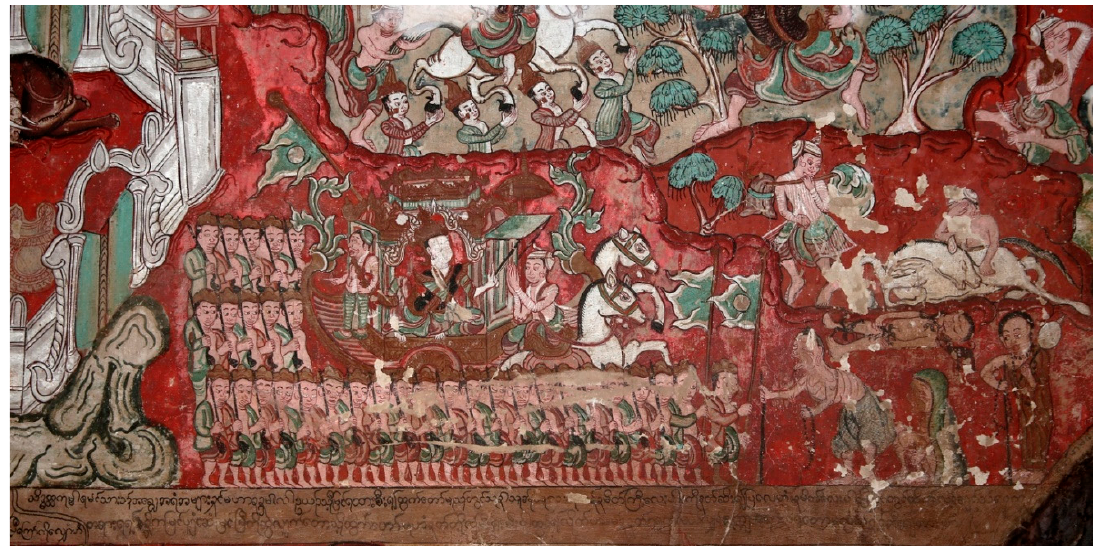
Figure 5. Amyint, Kuntaung Hpaya, 19th Century. Four Omens with embellishments—the dead man being attacked by crows, featuring also an immense army accompanying the garden sojourn, linked above to the Great Departure and, on the right side, the demise of the horse and the always-weeping charioteer dismayed by his master’s choice to abandon courtly life.